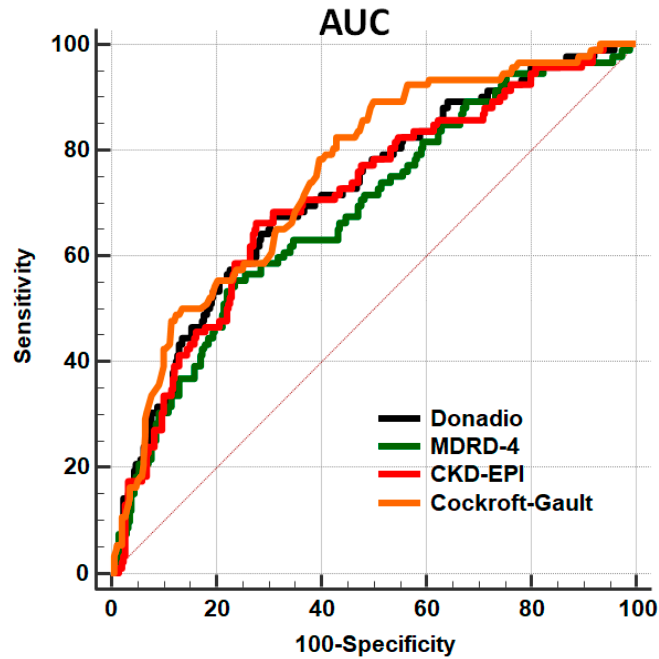
Figure 1. Area under the receiver operating characteristic curves (AUC) of the different eGFR formu-